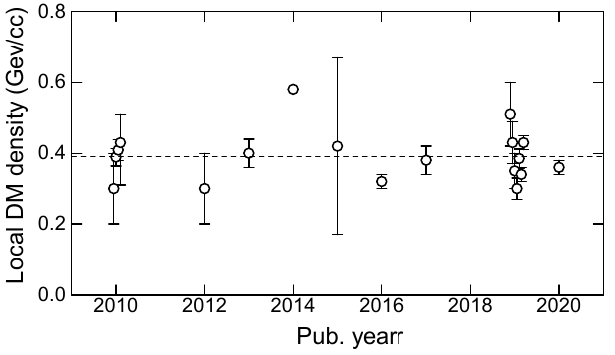
Figure 4. Local dark matter (DM) density from the literature (Table 4) plotted against publication year. The dashed line indicates a simple mean of the plots at ρ (cid:12) = 0.39 ± 0.09 GeV cm − 3